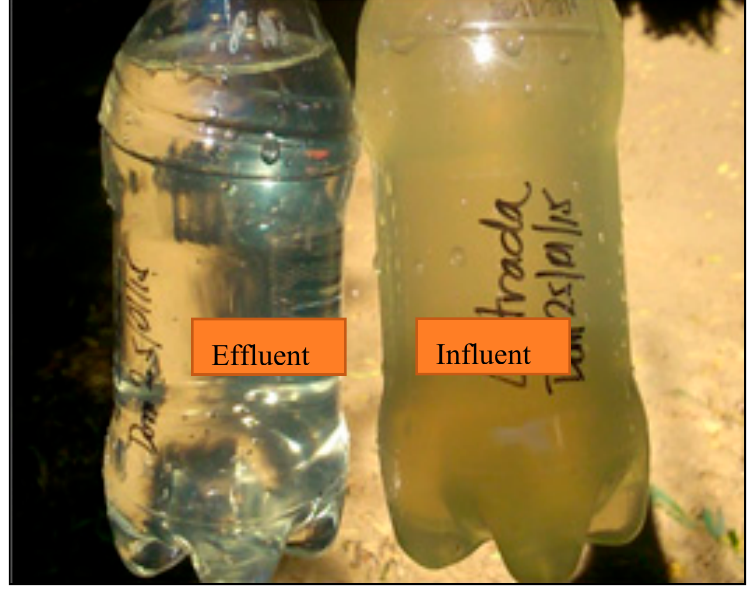
Figure 6. Effluent and influent sample. Figure 6. E ffl uent and influent